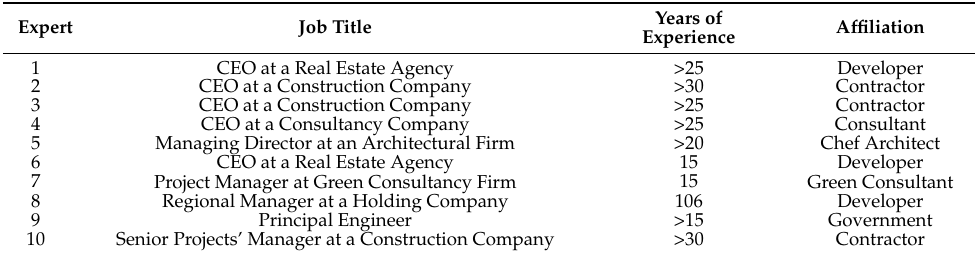
Table 2. The background details of the expert panel that validated the questionnaire